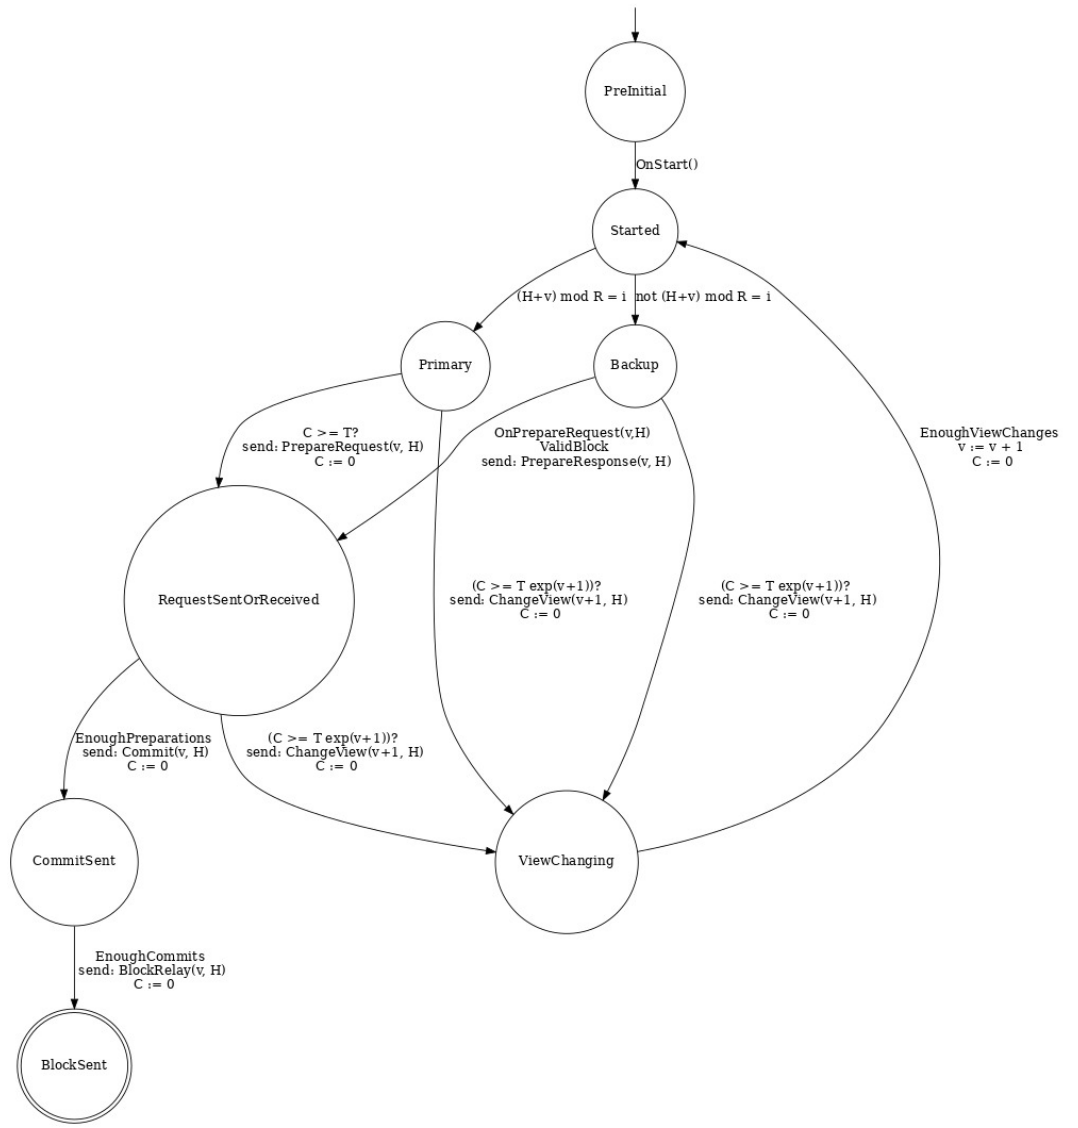
Figure 1. dBFT 2.0 diagram automatically generated by libbft